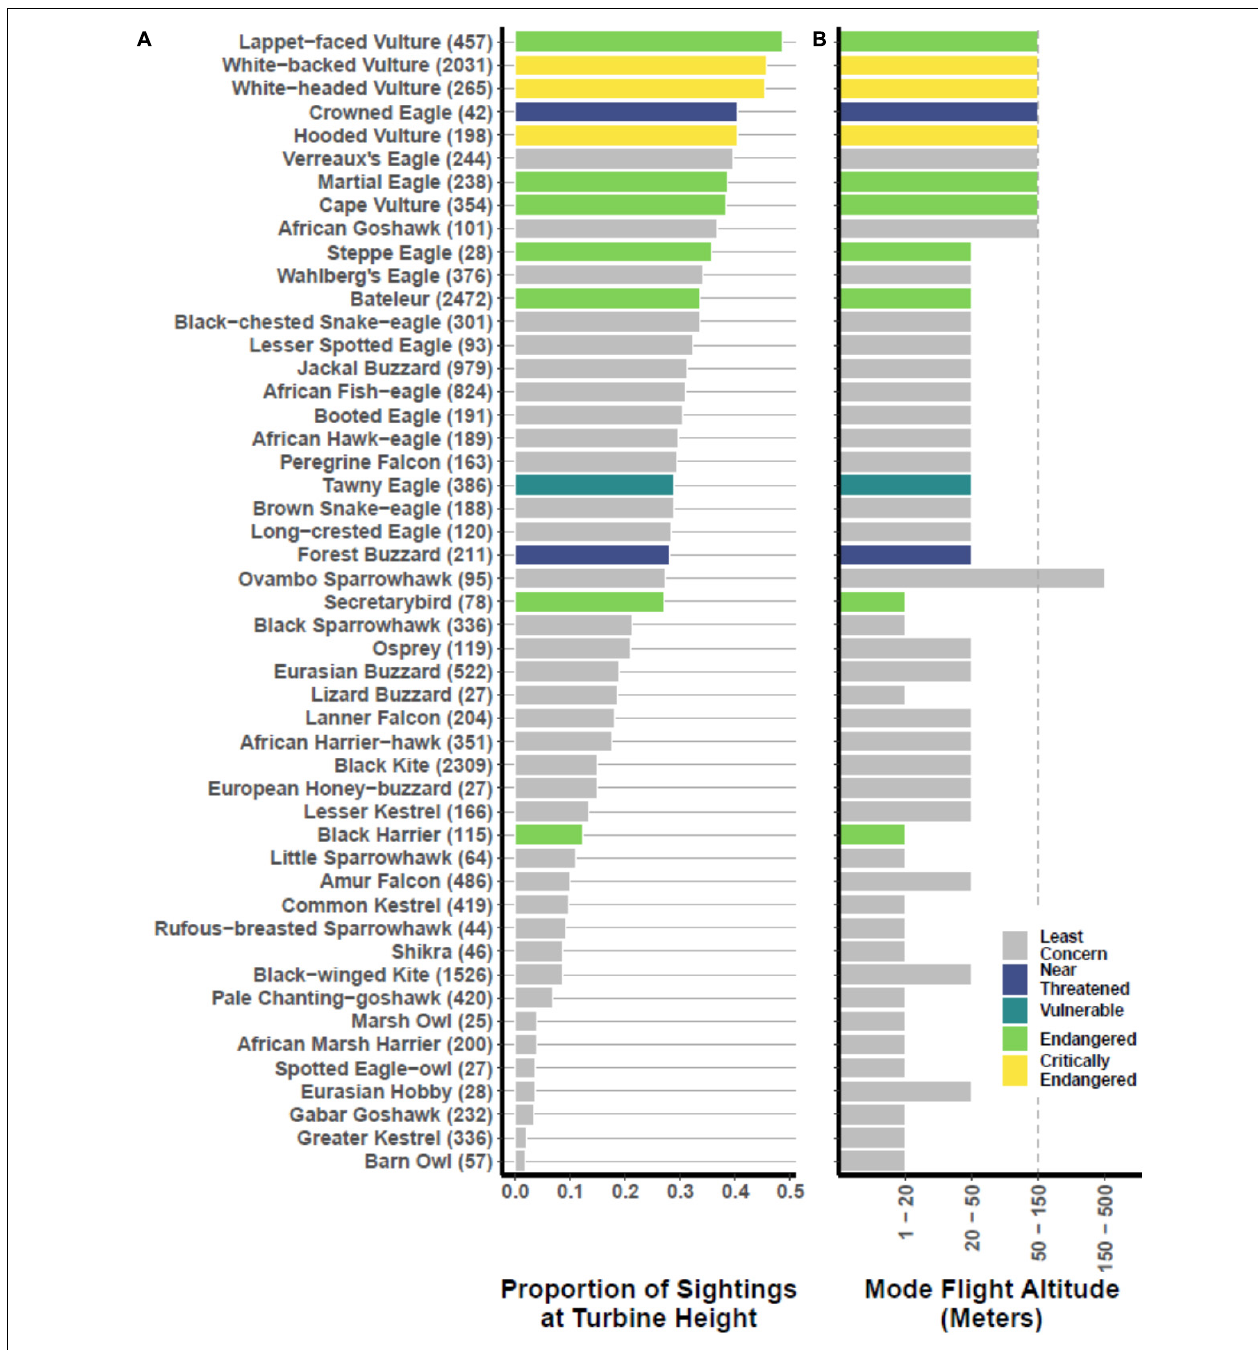
FIGURE 2 | (A) Proportion of observations of African raptor species that were flying at turbine height (50–150 m). Sample sizes are listed parenthetically. (B) The flight altitude category in which each species was most recorded (mode). Vertical dashed line represents maximum of the range of turbine heights. Colors represent the conservation status of each species. See Supplementary Table 1 for scientific